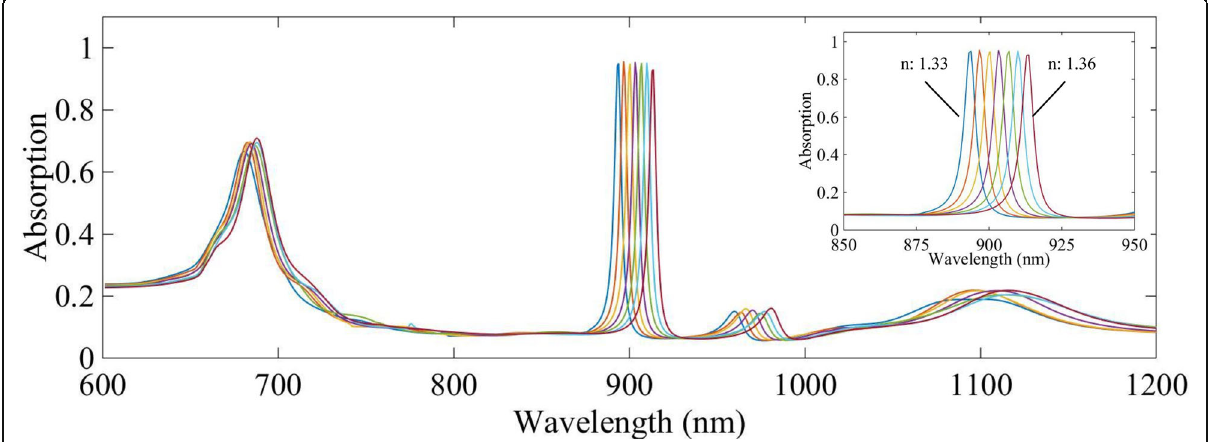
Fig. 4 Absorption peak varies with environment refractive index (from 1.33 to 1.36)